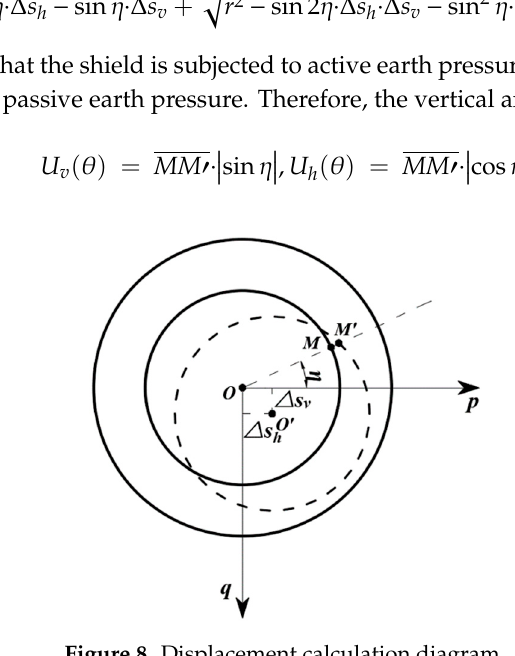
Figure 8. Displacement calculation diagram.